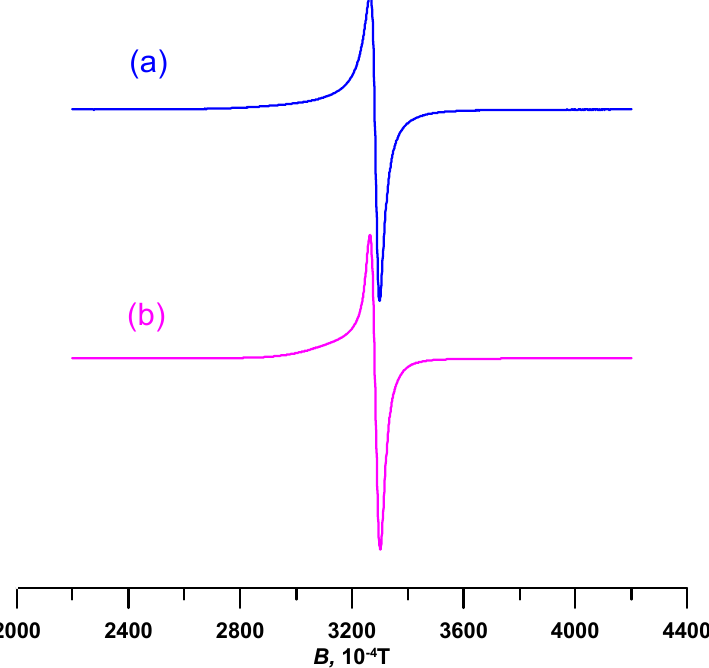
Figure 5. ( a ) Experimental EPR spectrum (blue line) recorded at RT and ( b ) calculated EPR spectrum (pink line) of powdered complex (I).